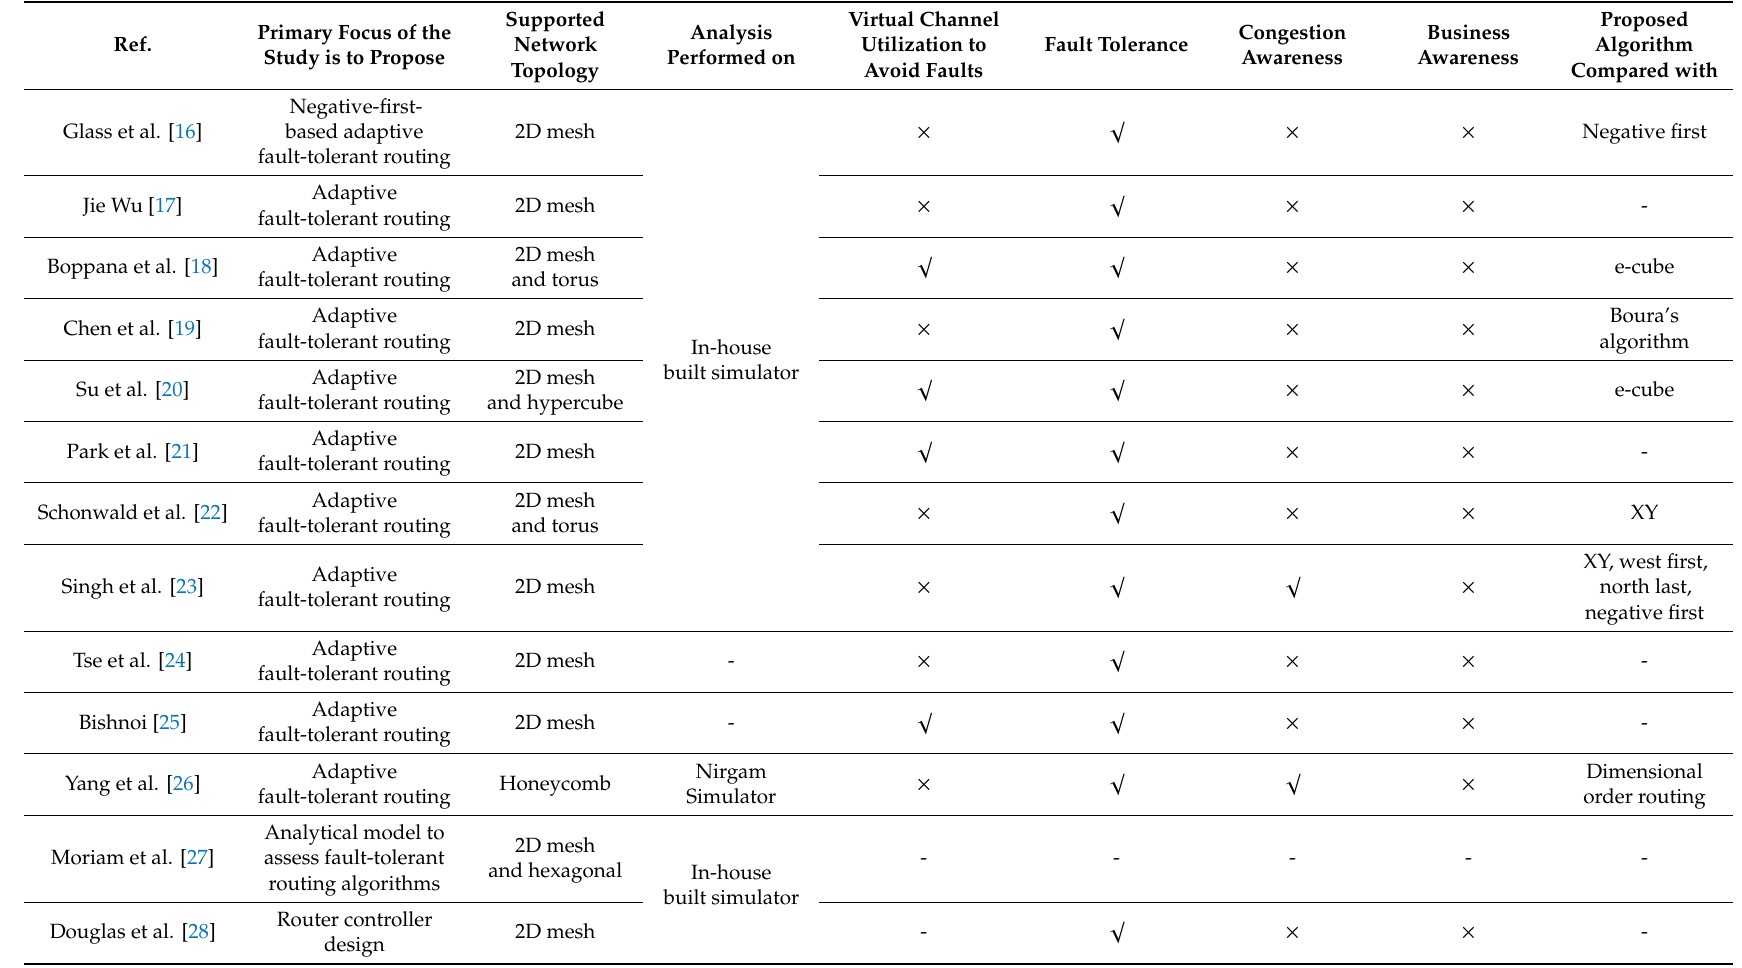
Table 1. Comparison of the state-of-the-art for routing in a network-on-a-chip